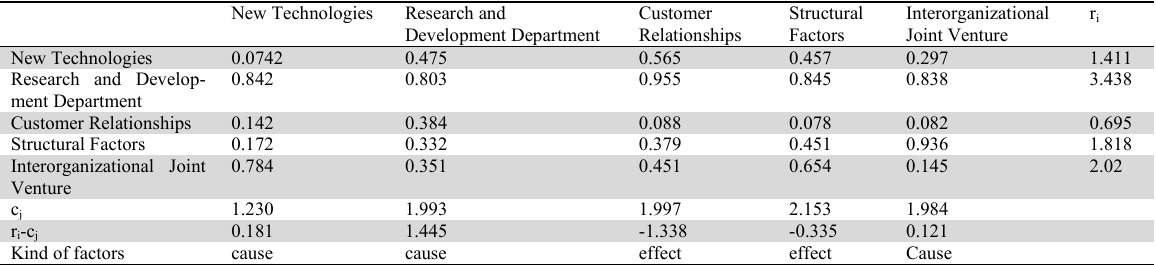
Total relation matrix (fuzzy DEMATEL output)